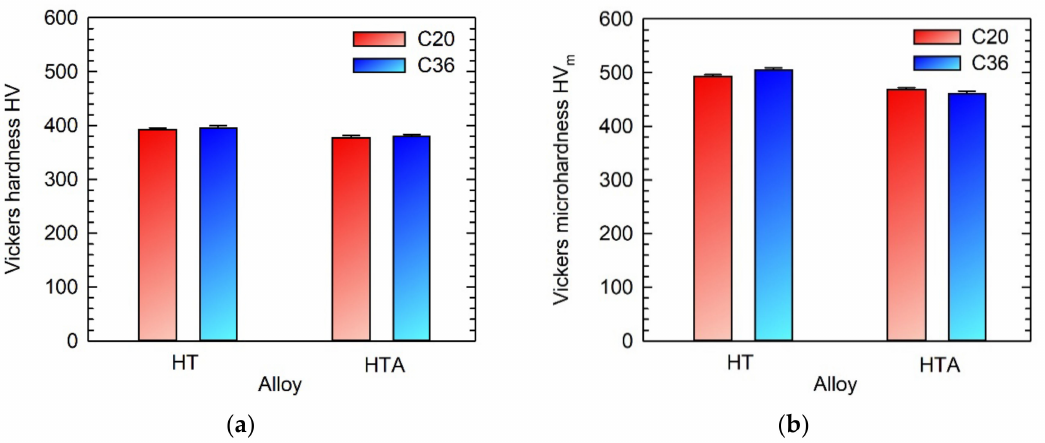
Figure 7. ( a ) Vickers hardness HV and ( b ) Vickers microhardness of lamellar grains HV m of C20 and C36 alloys after heat treatment and heat treatment combined with ageing. The type of alloys and applied treatments are marked in the